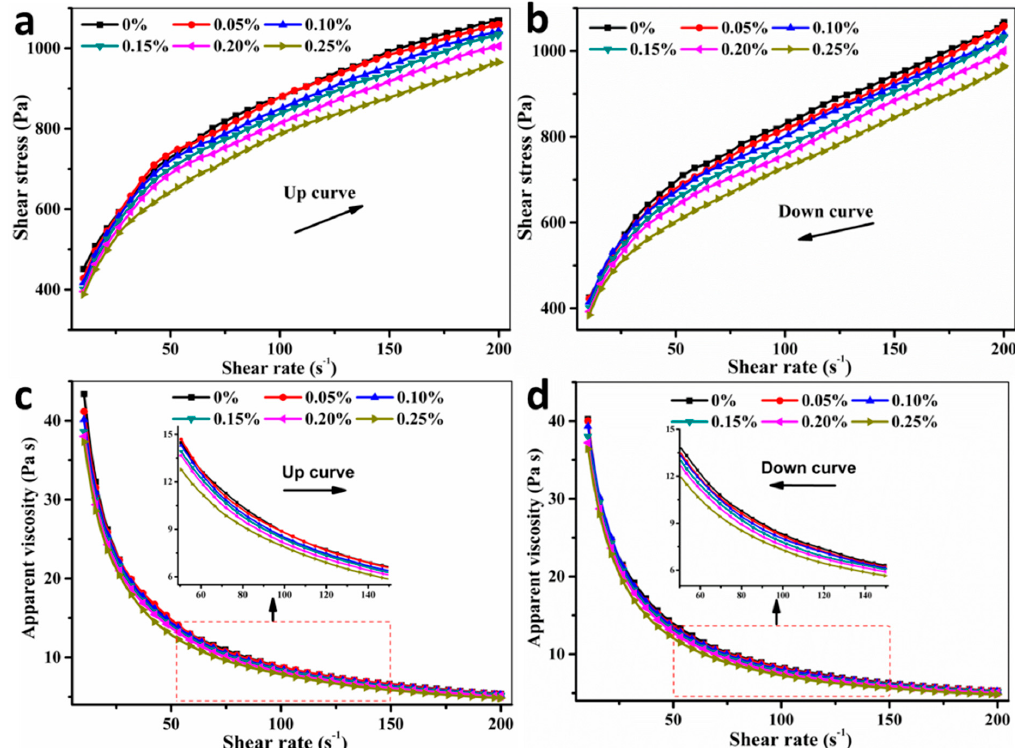
Figure 6. The rheology properties of the fresh SAC paste with different additions of TA under a varying shear rate from 10–200 s − 1 : ( a , b ) shear stress of up curves and down curves; ( c , d ) apparent viscosity of up curves and down curves.